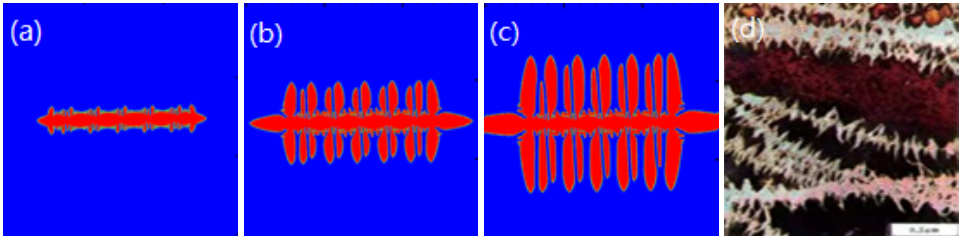
Figure 7. When K 0 = 1.6, the string crystals shape of is obtained by numerical simulation. (( a – c ) are the numerical simulation results with time iteration steps of 1000, 3000 and 5000, respectively. ( d ) is the experimental